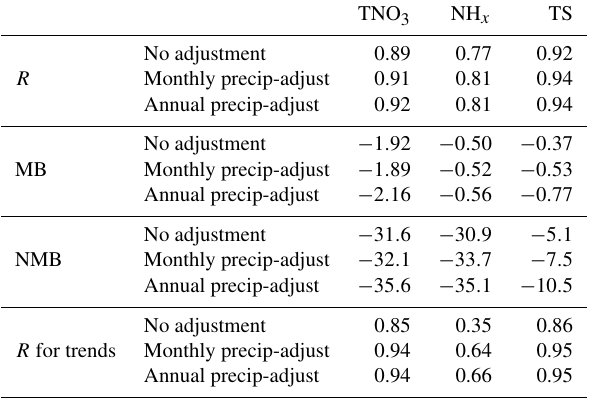
Table 1. Correlation coefficient ( R ), mean bias (MB, kgha − 1 ) , and normalized mean bias (NMB, %) for the sum of the annual accumu- lated wet deposition (WDEP) between the model and NADP sites from 1990 to 2010, including both the model values with and with- out applying monthly and annual precipitation adjustment (precip- adjust). The R for trends are the correlation coefficient for the 21- year changes of the wet deposition (TNO 3 , NH x , and TS) between the model and the